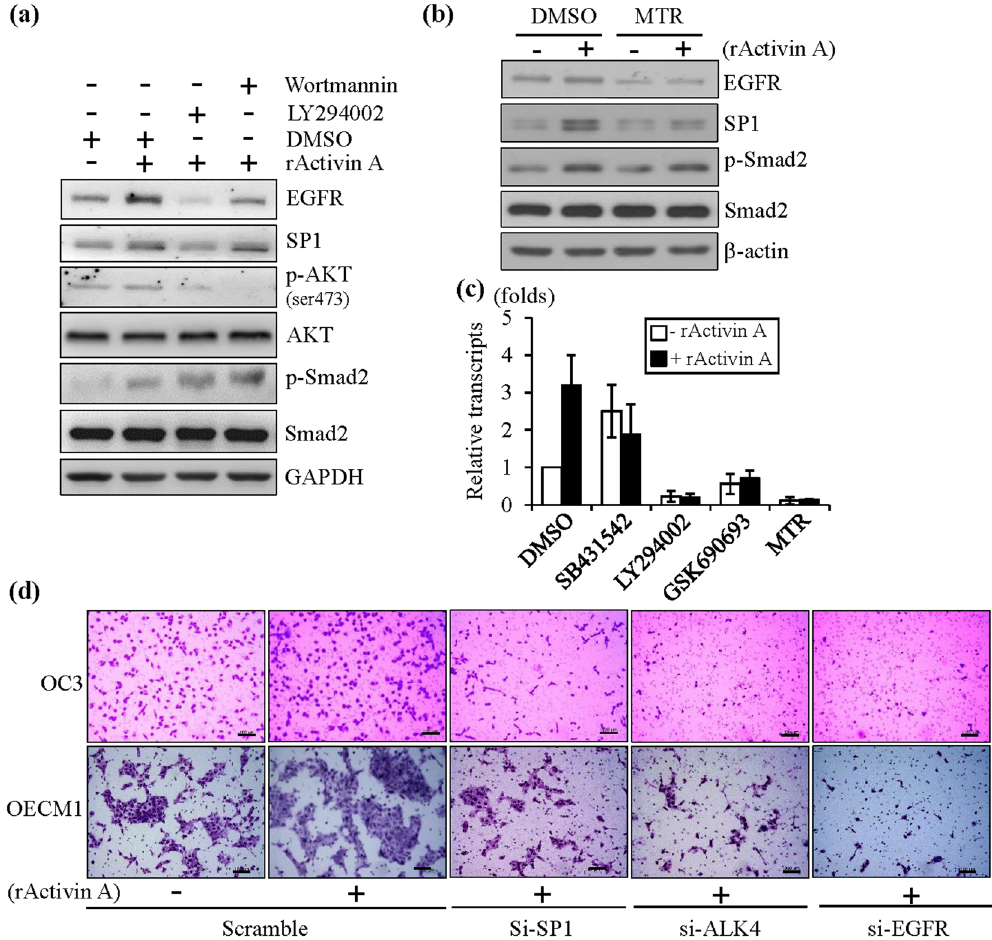
Figure 5. Blocking SP1 expression attenuated the expression of EGFR and repressed the migration ability of OSCC cells. ( a ) Protein expression of EGFR, SP1, p-Smad2, Smad2, SP1, p-AKT (ser473), and AKT was examined in DMSO-treated OC3 cells with or without rActivin A or Wortmannin-, LY294002-treated OC3 cells with rActivin A. GAPDH expression was used as an internal control for western blotting. ( b ) Protein expression of EGFR, p-Smad2, Smad2, and SP1 was examined in DMSO-treated OC3 cells with or without rActivin A or MTR-treated OC3 cells with rActivin A. β -actin expression was used as an internal control for western blotting. ( c ) EGFR transcripts were examined in DMSO-treated OC3 cells with or without rActivin A in the presence of SB431542, LY294002, GSK690693 or MTR. The expression of β -actin was used as an internal control in qRT-PCR. ( d ) Inhibition of SP1 , ALK4 and EGFR expression via RNAi repressed the rActivin A-induced cell migration ability of OSCC cells, as revealed via a transwell migration assay (scale bar: 100 µ